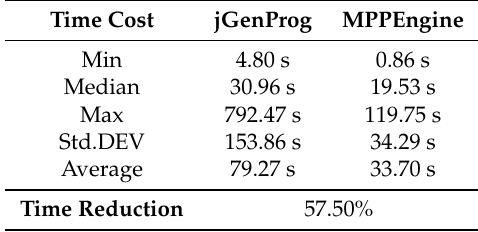
Table 2. Time taken to validate a program variant by jGenProg and